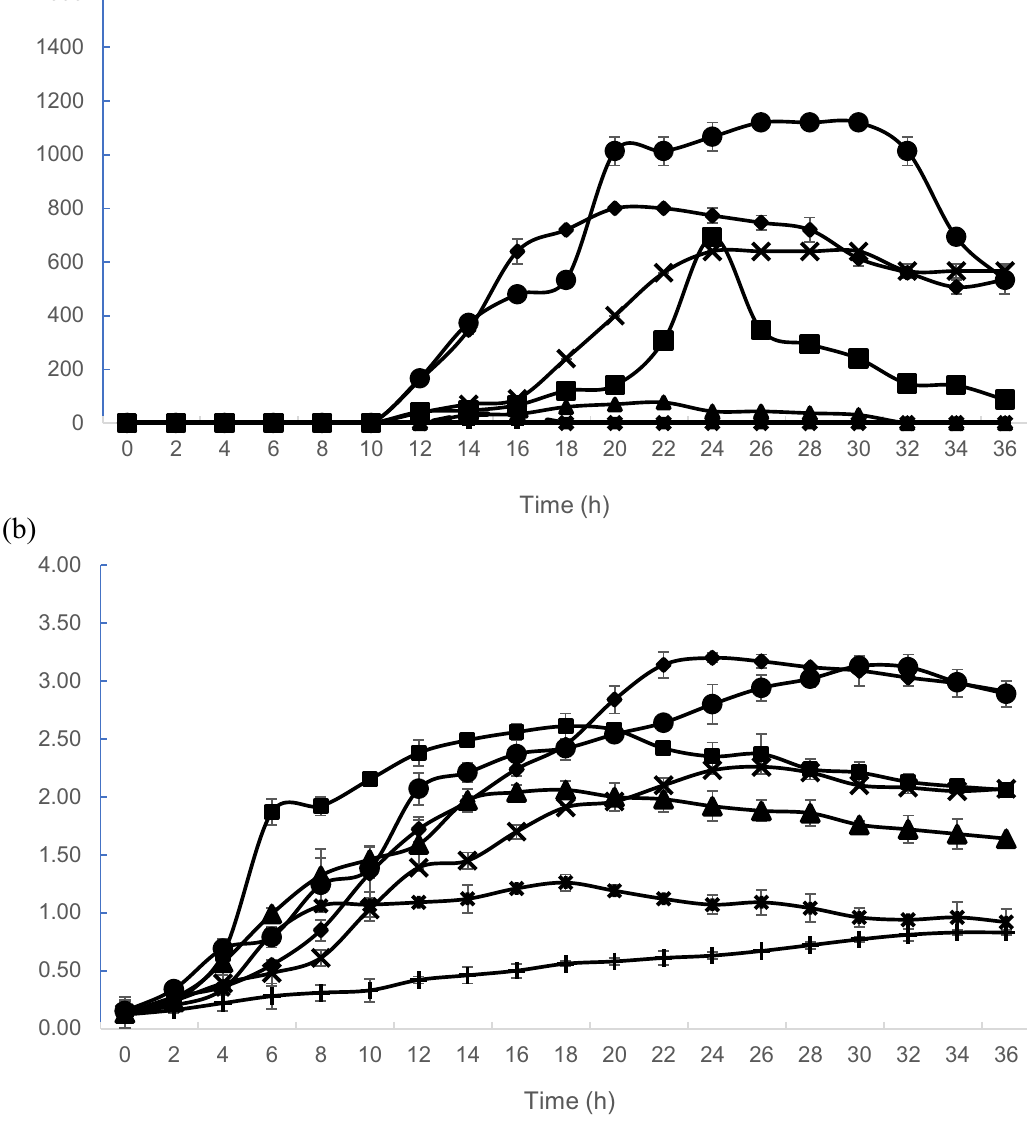
Figure 3. Effects of different carbon glucose concentrations on antimicrobial activity of postbiotic RS5 and biomass produced by L. plantarum RS5. ( a ) Antimicrobial activity profiles of postbiotic RS5 and ( b ) growth of L. plantarum RS5 in control MRS medium (x) and growth medium containing 0 g/L (+); 5 g/L (*); 10 g/L (filled triangle); 15 g/L (filled square); 20 g/L (filled circle) and 40 g/L (filled rhombus) of glucose. Values presented are mean ± SEM, n = 3. Vertical bars represent